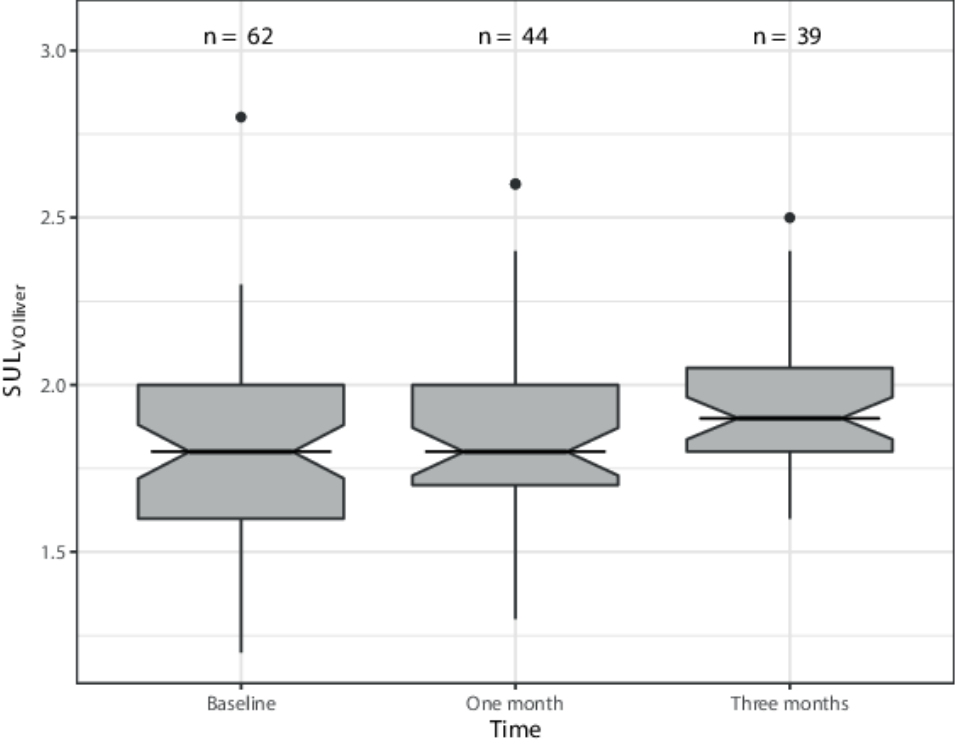
Figure 2. Changes in SUL VOI,liver over time compared to baseline values. Table 3. Relation of the SUL VOI over time based on linear mixed effects regression analyses. Independent Variable Mean Change in SUL VOI Per Month Increase in Time (95%CI); p -Value